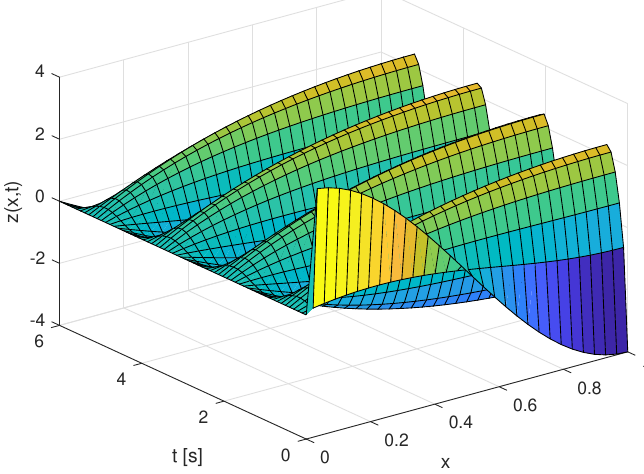
Figure 6. Plot of the solution surface for λ = −